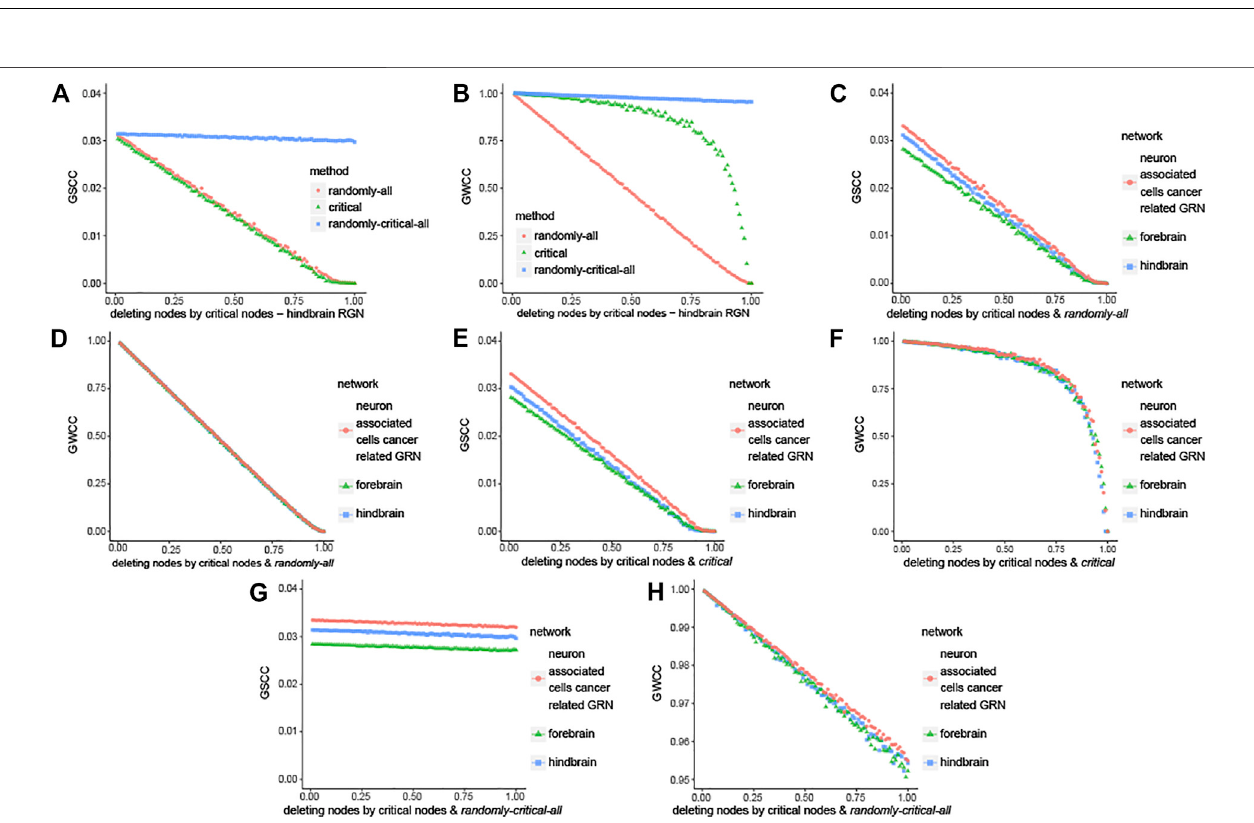
FIGURE 5 | Robustness analysis of node classi fi cation. Here we noted the three strategies by the following ways: Firstly, deleting nodes randomly in the whole hindbrain GRN(noted as randomly — all ).Secondly,deletingcritical nodes randomly (noted as critical ).Lastly deletingthe same number ofnodes asthe second strategy inthewholehindbrainGRN,andwhichnodesaredeletedisrandomly(notedas randomly — critical — all ). (A) Thechangeofgiantstronglyconnectedcomponent(GSCC) in hindbrain GRN with three methods that are different in the way of deleting critical nodes. (B) The change of giant weakly connected component (GWCC) in hindbrain GRN with three methods that are different in the way of deleting critical nodes. (C, D) Comparison in the way of deleting nodes randomly in the whole brain- speci fi c GRN respectively. (E, F) Comparison in the way of critical . (G, H) Comparison in the way of randomly — critical — all .